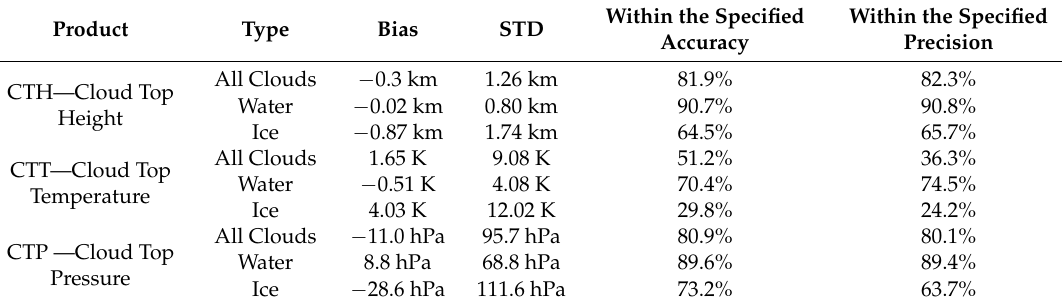
Table 4. S-NPP VIIRS cloud top products performance.